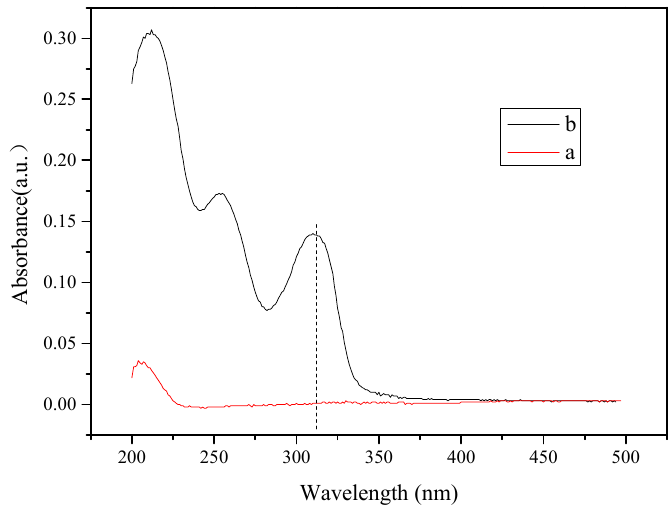
Figure 4. Uv-vis spectra of target analyte (0.05 μ g /mL) before (a) and after (b) enrichment.